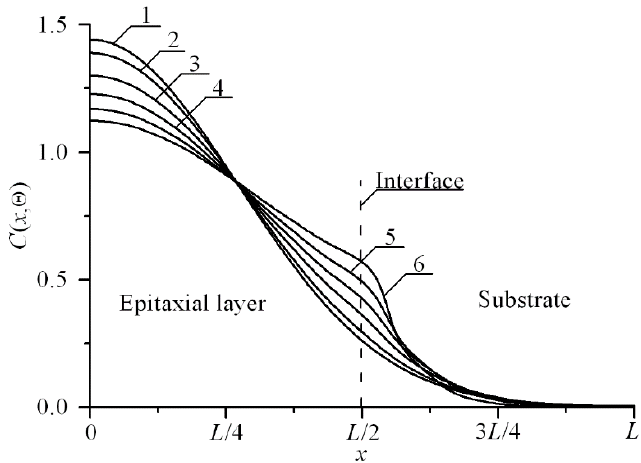
Fig. 2. Distributions of concentration of infused dopant in heterostructure from Fig. 1 in direction, which is perpendicular to interface between epitaxial layer